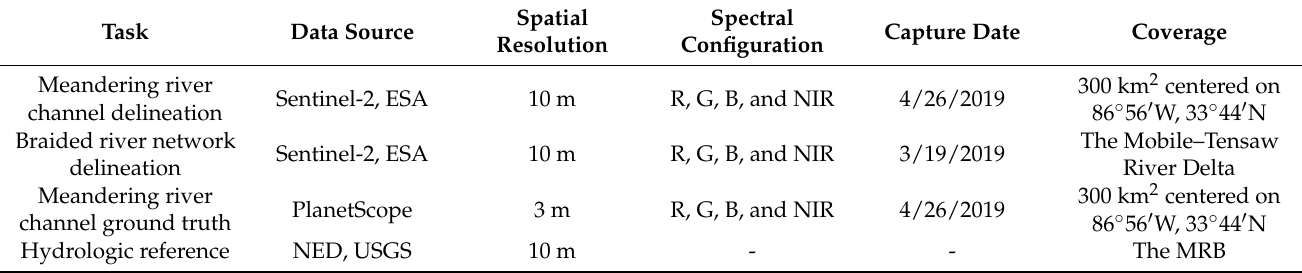
Table 1. Dataset